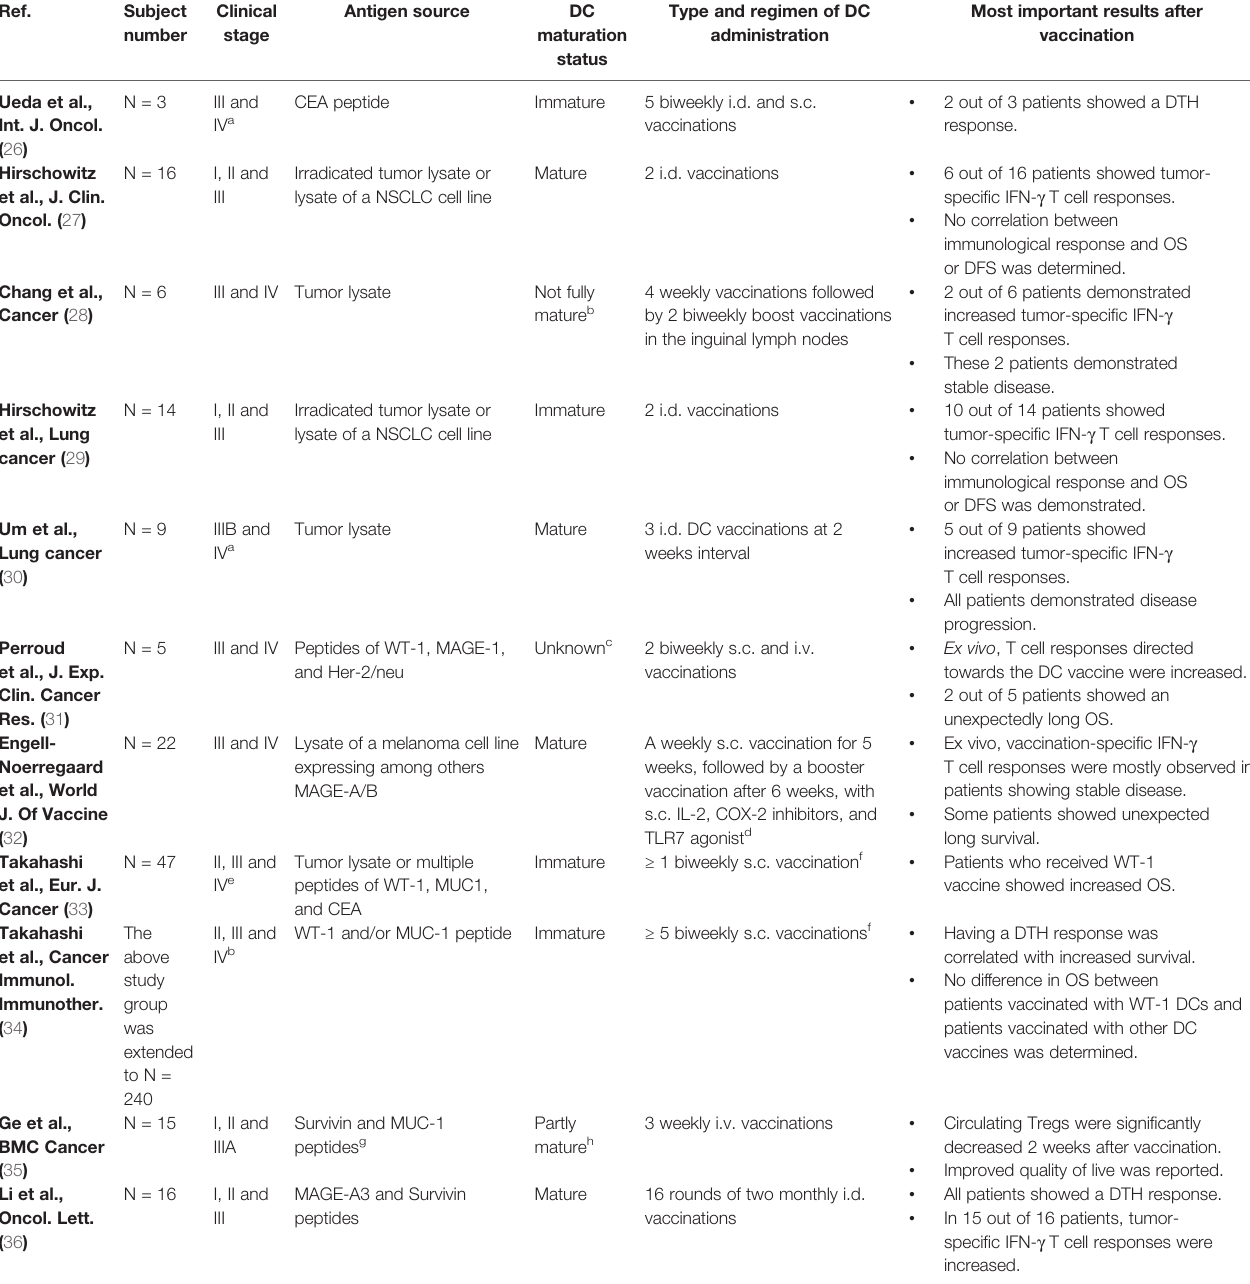
TABLE 1 | Characteristics of studies in which DC vaccination monotherapy was performed in NSCLC.